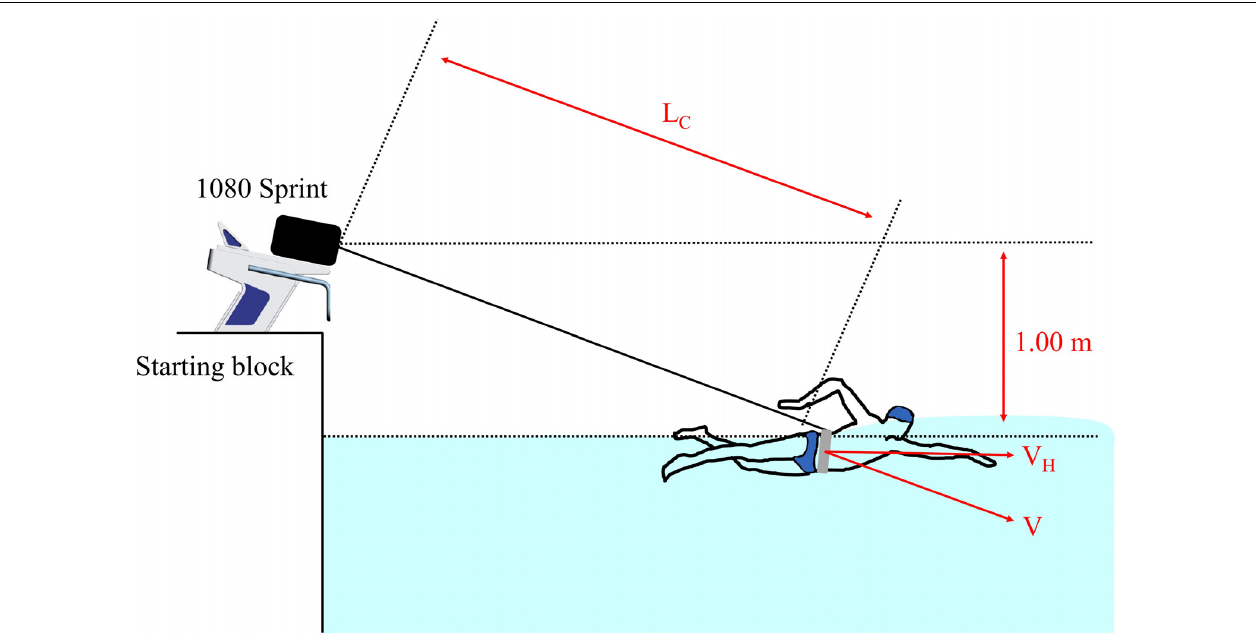
FIGURE 2 | Testing setting for semi-tethered swimming trials. L C , V, and V H show the length of the cord, velocity measured by the machine, and the horizontal component of the measured velocity, respectively.